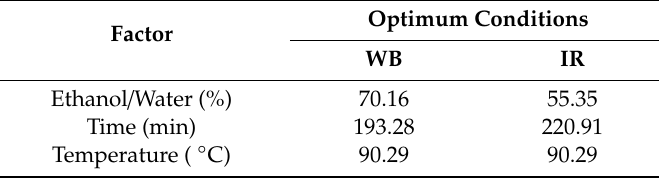
Table 3. Optimum extraction conditions for WB and IR.